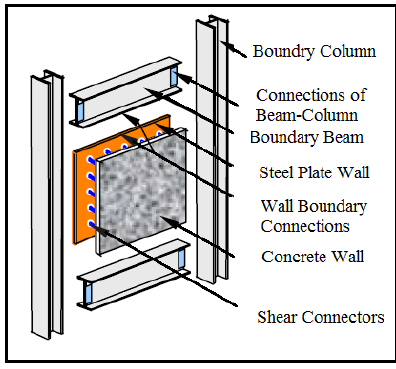
Figure 1. Composite steel shear wall.